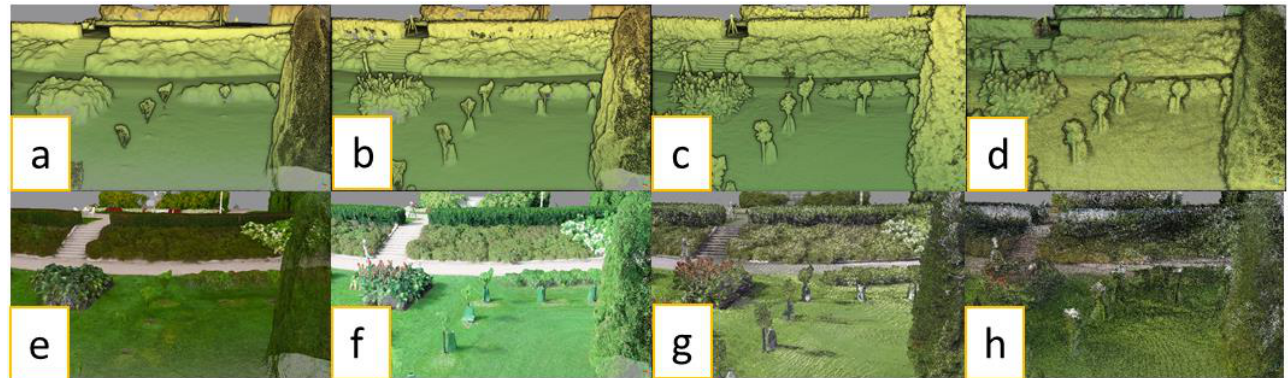
Figure 8. Comparisons of point clouds for very small trees. In the top row, the point clouds are colored with the height ramp and in the bottom row with RGB